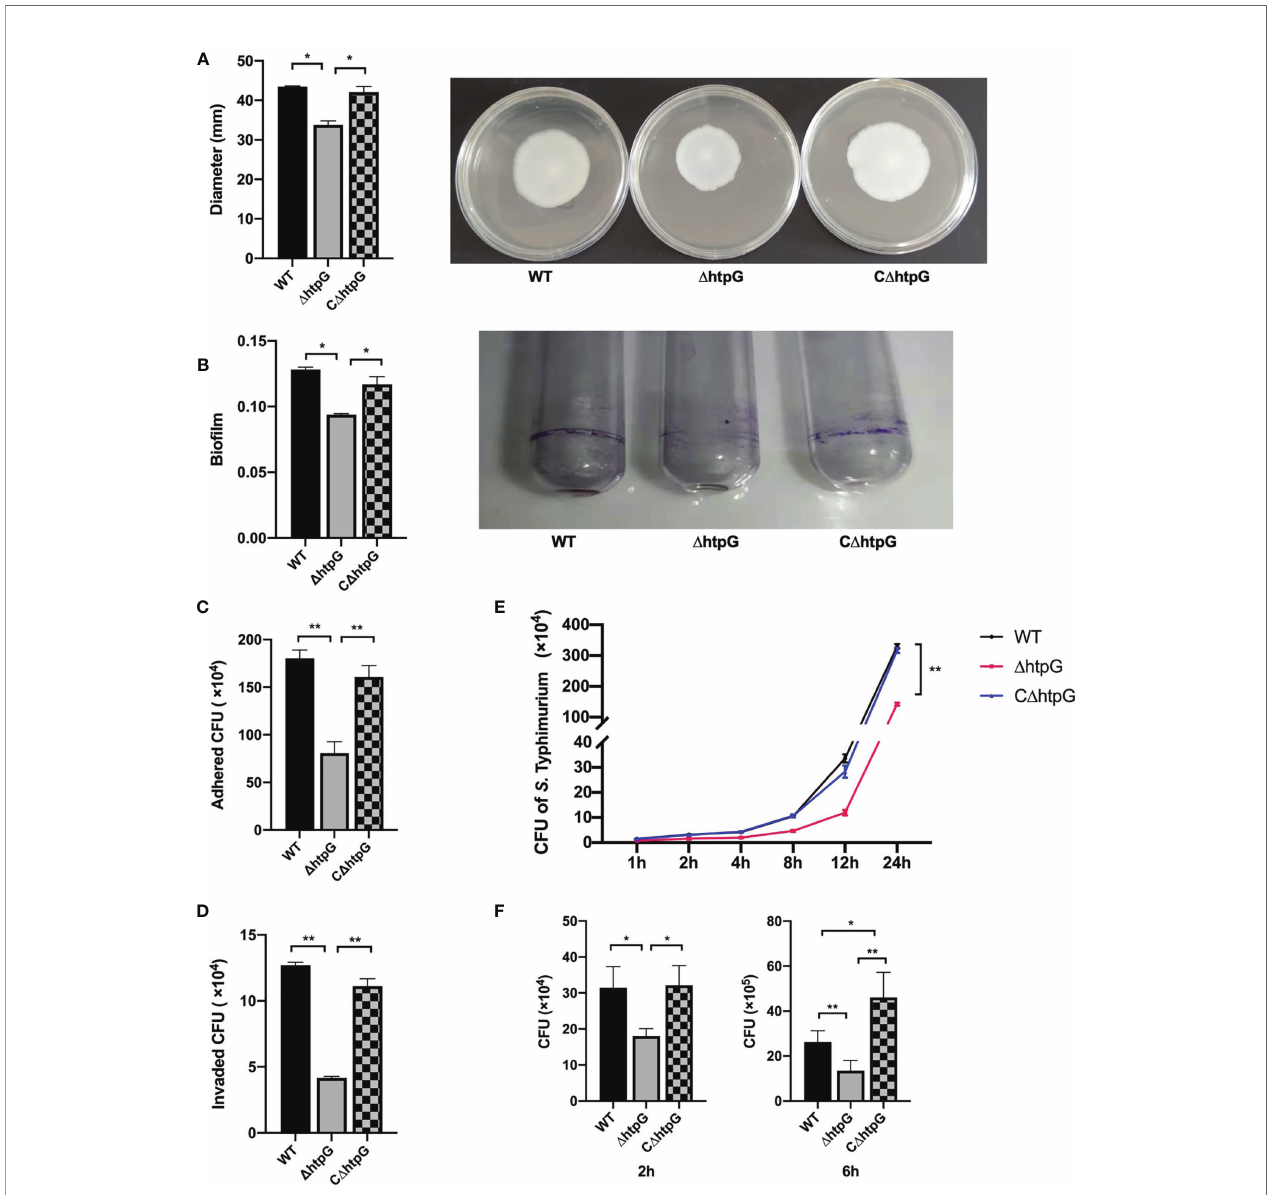
FIGURE 3 | (A) Diameter of swimming circle of S. Typhimurium in semi-solid agar medium (left) and the representative graph (right), n = 4. (B) S. Typhimurium bio fi lm formation ability (left) and the representative graph: crystal violet stained the bio fi lm produced by S. Typhimurium in a glass tube (right), n = 6. (C) The number of S. Typhimurium attached to IPEC-J2 cells, n = 4. (D) The number of S. Typhimurium invading IPEC-J2 cells, n = 4. (E) The number of S. Typhimurium proliferating of WT strains, D htpG strains, and C D htpG strains in IPEC-J2 cells, n = 4. (F) The number of S. Typhimurium proliferating in RAW264.7 cells, n = 4. The result is shown as the mean ± standard error, * means p < 0.05, ** means p < 0.01. WT means S. Typhimurium wild-type strains; D htpG means S. Typhimurium HtpG mutant strains; C D htpG means S. Typhimurium HtpG complement